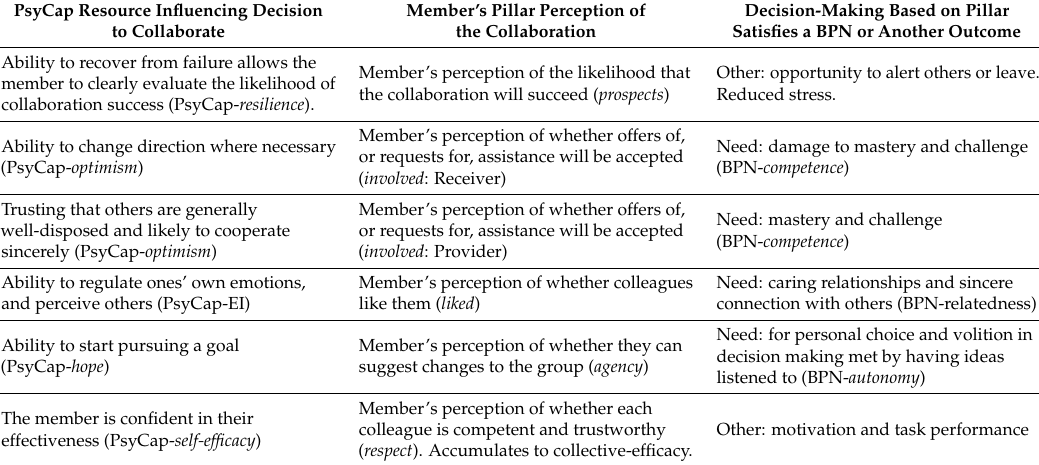
Table 3. Translation of PsyCap resources via PILAR into BPN and other